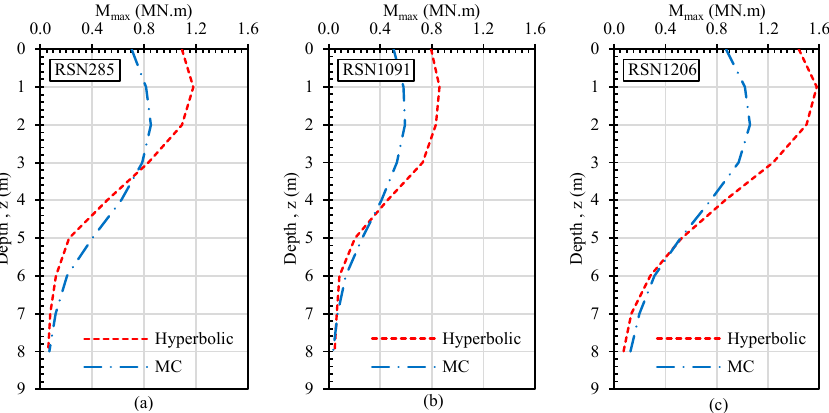
Figure 17. Maximum bending moment vs. depth using Hyperbolic and MC models ( a ) RSN285, ( b ) RSN1091, ( c ) RSN1206. Table 6. Summary of the numerical analysis results under various